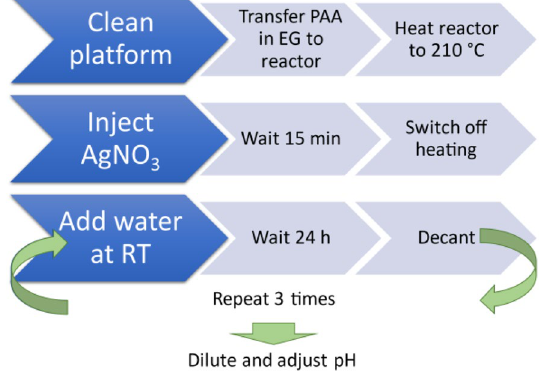
Figure 1. Schematics of the overall synthesis and purification processes of herein described silver